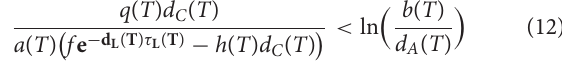
as opposed to when the resource species’ developmental delay is short relative to that of the consumer (i.e., τ J → 0, τ L > 0):